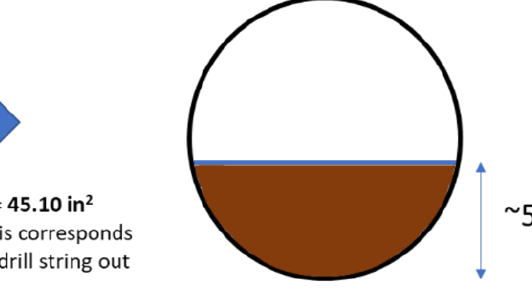
Figure 14. ( a ) Well trajectory ( b ) Well inclination profile (negative sign indicates downward depth into the sub-surface).